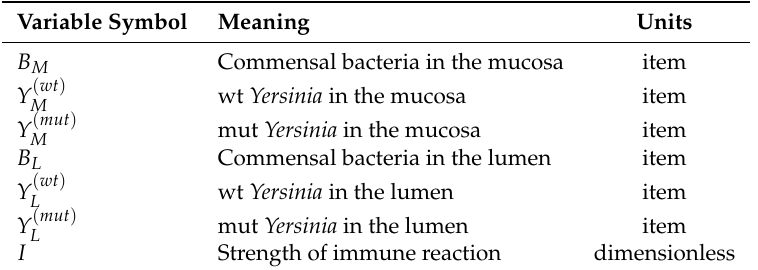
Figure 1. An overview of the Yersinia enterocolitica population dynamics model. Filled circles represent the entity pool nodes for the populations of Ye in their respective compartments as well as the strength of the immune reaction I . Table 1 explains the notations used in the model and this figure. The black arrows represent processes with an impact on the population dynamics of the entity pools. Arrows pointing from empty set symbols to pool nodes denote an increase in the population size or a decrease if the process arcs point from entity pools to empty sets. Migration across compartments of the respective populations appears as vertical process arcs. Some of these processes receive stimulating effects from the immune reaction or from the size of the Ye populations within the mucosa, as colored arcs indicate. Reference [10] provides a more detailed description of the model’s structure. Table 1. The variable symbols and their meaning. The lumen is abbreviated with L , the mucosa as M . We also indicate each variable with mut or wt to denote to which population they refer. An upper-case I refers to the immune system. SBML [26,27] defines the units item and dimensionless to indicate that a quantity occurs in a piece number or that its unit originates from the cancellation of other